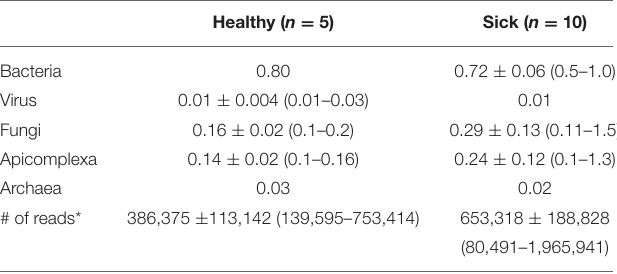
TABLE 2 | The composition (%) of major circulating microbial DNA present in healthy and sick equine blood